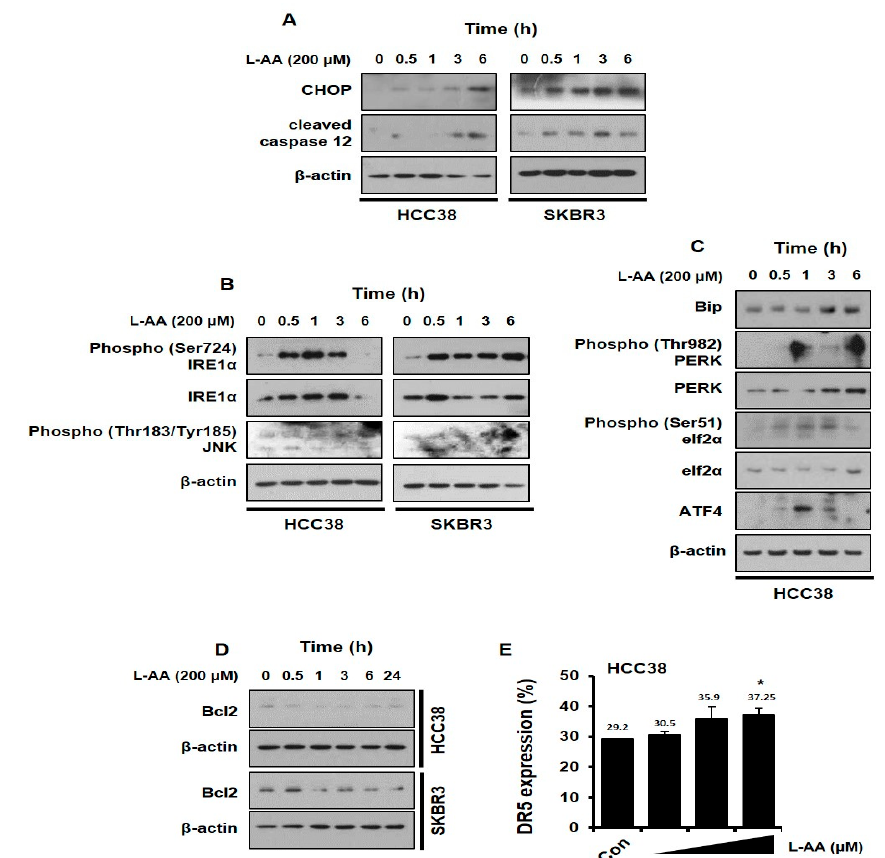
Figure 4. L-AA increases endoplasmic reticulum (ER) stress in breast cancer cells. ( A , D ) HCC-38 or SKBR3 cells were treated with 200 µ M of L-AA for indicated hours, and then western blotting was performed. β -actin was used as the loading control. ( A ) Expression levels of C / EBP homologous protein ( CHOP ) and cleaved caspase 12. ( B ) Protein levels involved in ER stress associated inositol-requiring endonuclease 1 ( IRE1 ) signaling pathway. ( C ) Protein levels involved in ER stress-related PKR-like ER kinase ( PERK ) signaling pathway. ( D ) B-cell lymphoma 2 ( Bcl2 ) expression levels ( E ) HCC-38 cells were treated with 200 µ M of L-AA for 24 h and stained with anti- DR5 (death receptor 5) primary antibody (1:100) and –AlexaFluor-488 secondary antibody (1:1000). DR5 -positive cells were detected by LSRFortessa flow cytometry. Data are shown as the mean of three independent experiments, and the error bars represent standard deviation (SD). * p < 0.05 versus the control